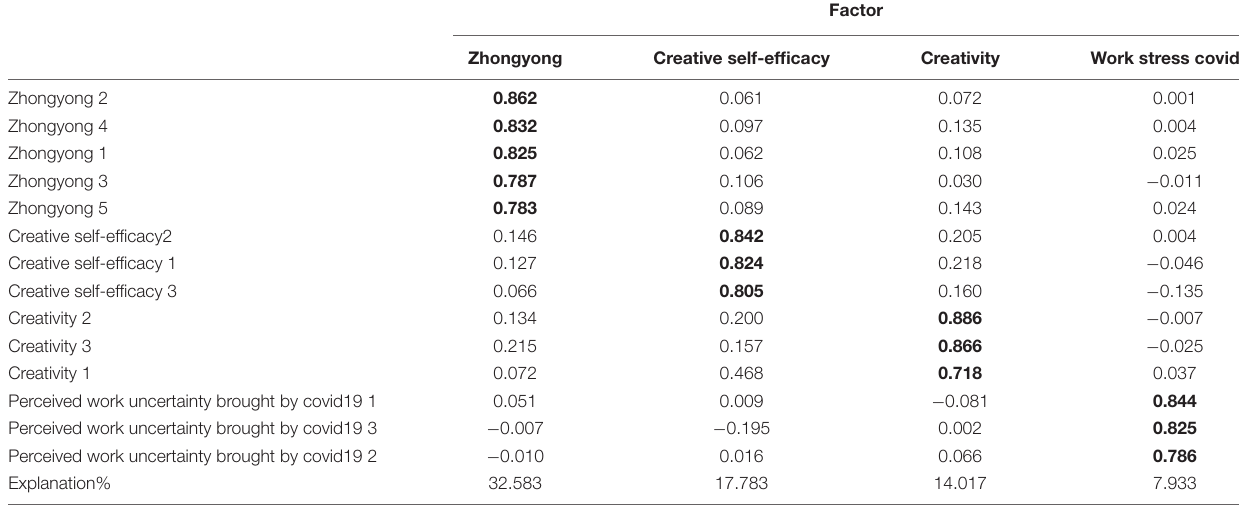
TABLE 3 | Exploratory factor